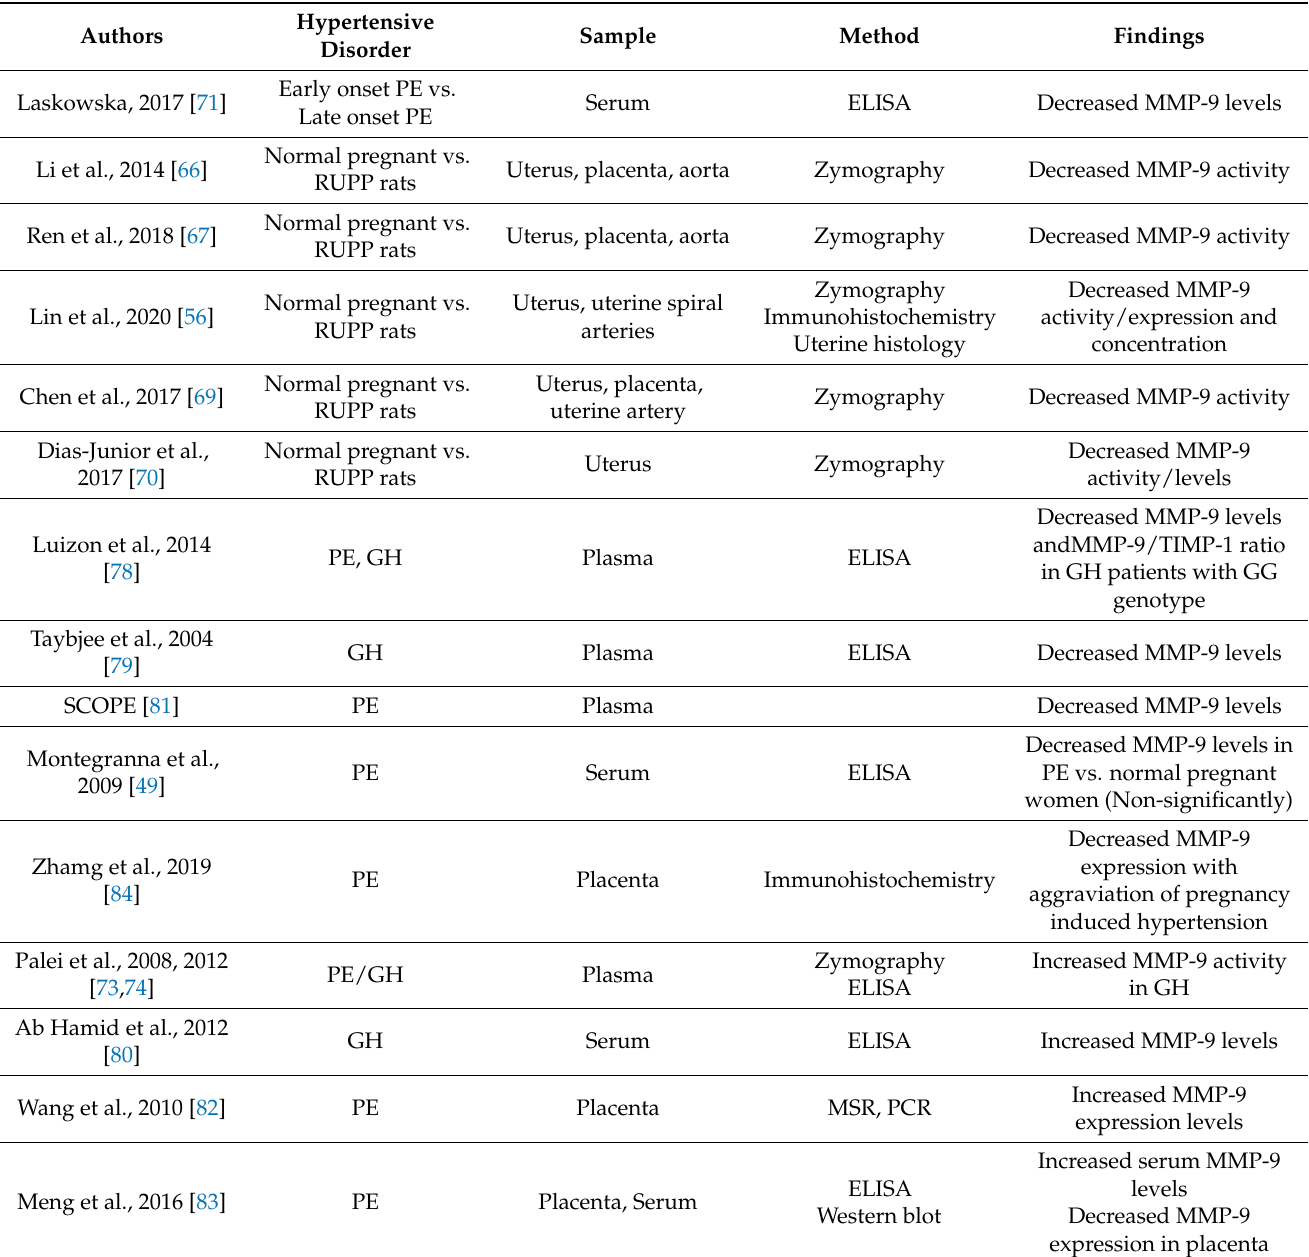
Table 2. Levels of MMP-9 in samples of patients with hypertensive disorders of